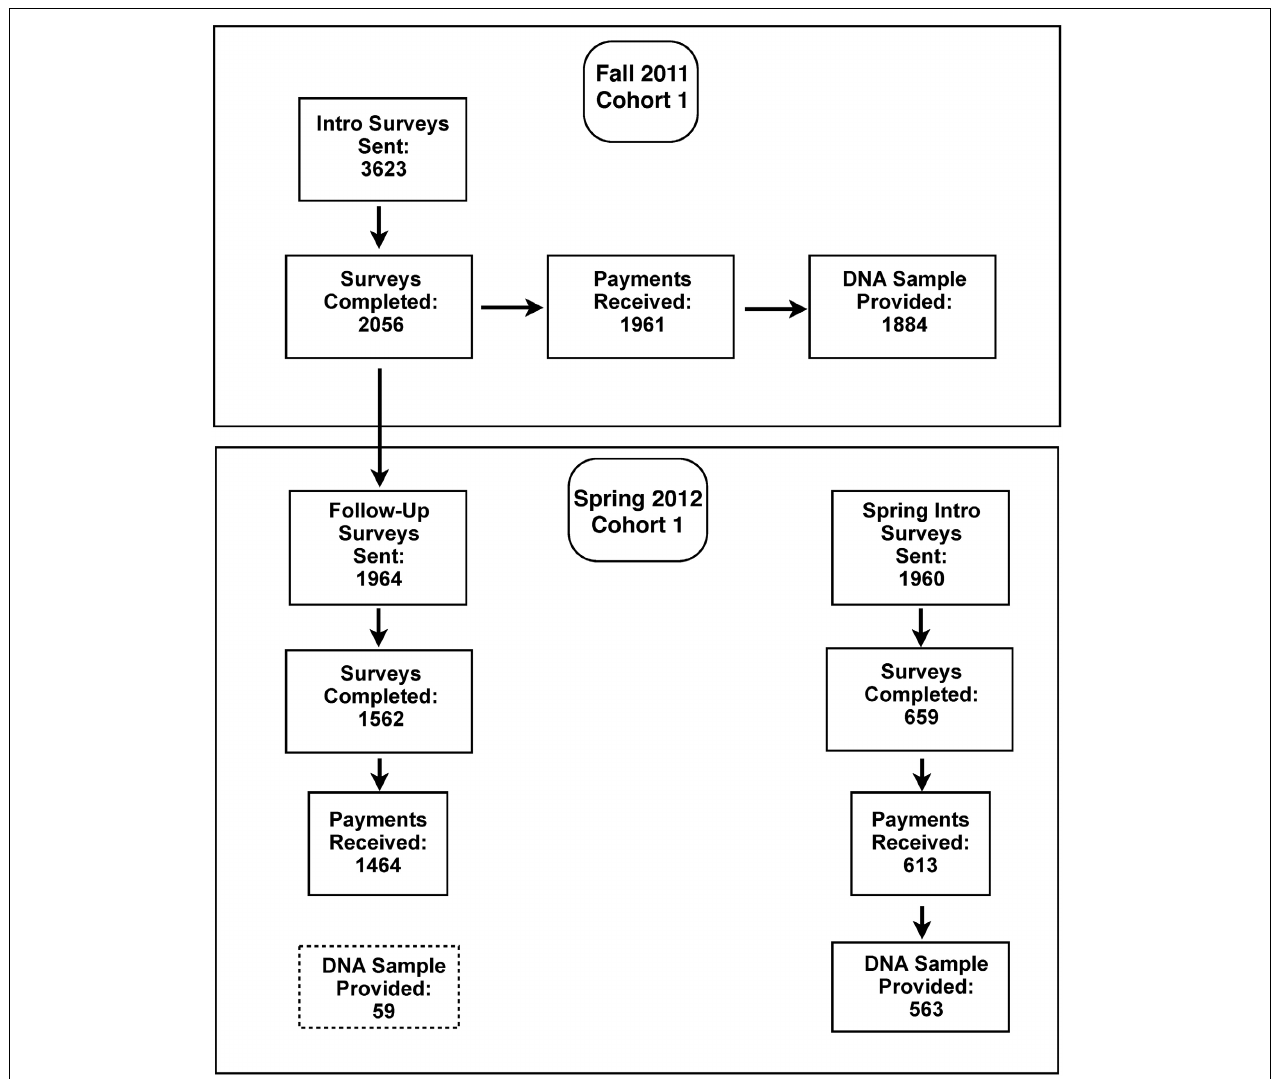
FIGURE 1 | Overview of participation rates for Cohort 1 across the first year of Spit for Science.